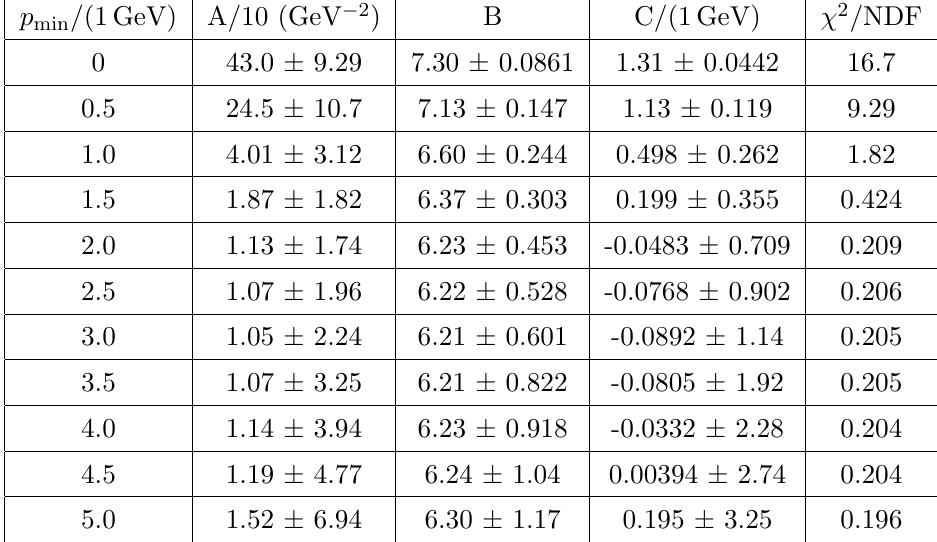
Table 11. Fitted values of parameters in eq. (E.3) for the ALICE dataset at p s = 5 : 02 TeV in